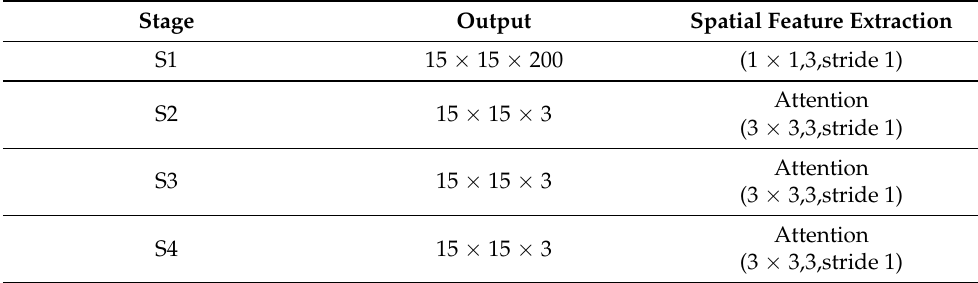
Table 1. The detailed structure of Spatial Feature